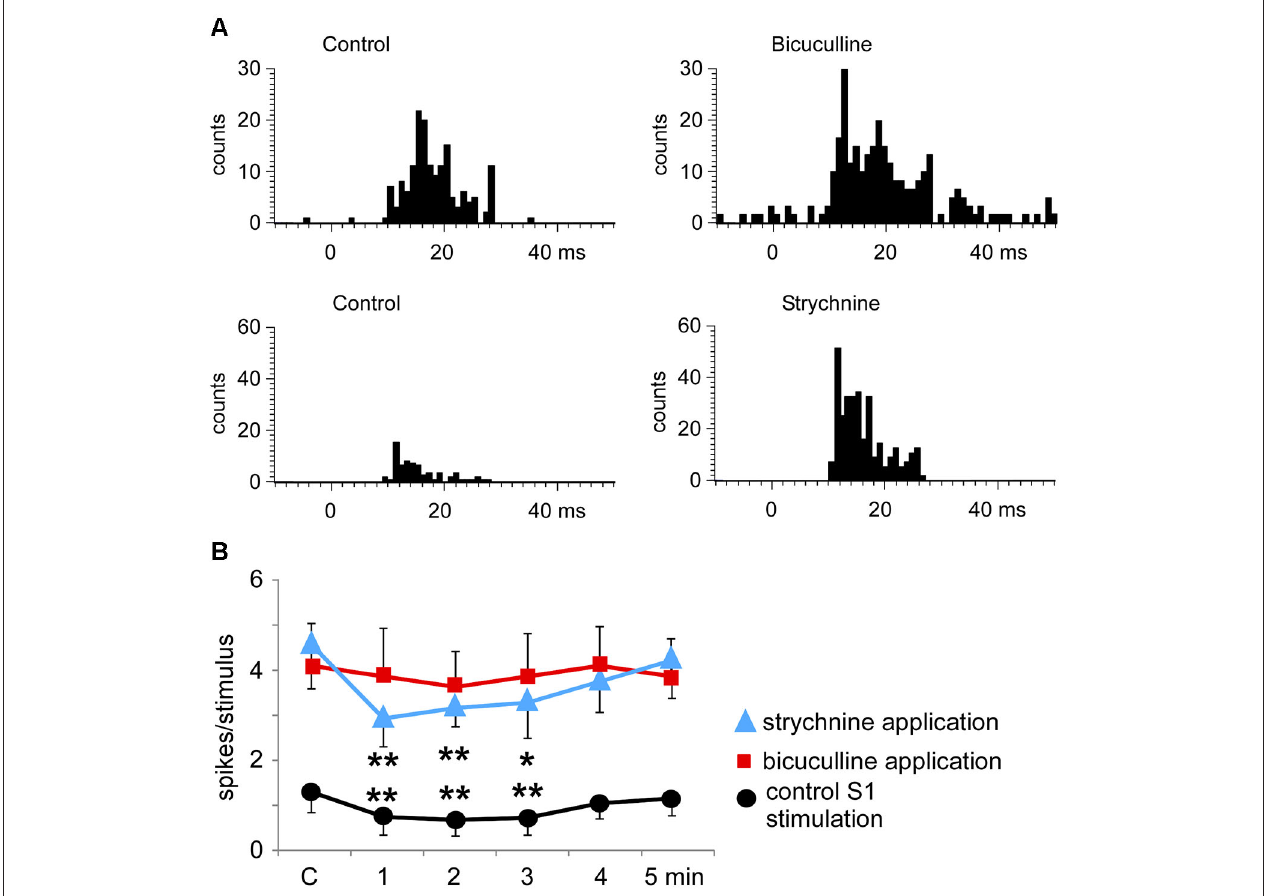
after the application of an SI stimulation train. SI cortical stimulation inhibited Pr5 tactile responses after application of saline solution ( n = 12; black circles), but the effect was blocked by bicuculline ( n = 9; red squares). However, strychnine application did not affect the long-lasting cortical-evoked inhibition ( n = 7; blue triangles). * P < 0.05, ** P < 0.01 statistical significance after cortical stimulation train with respect to control